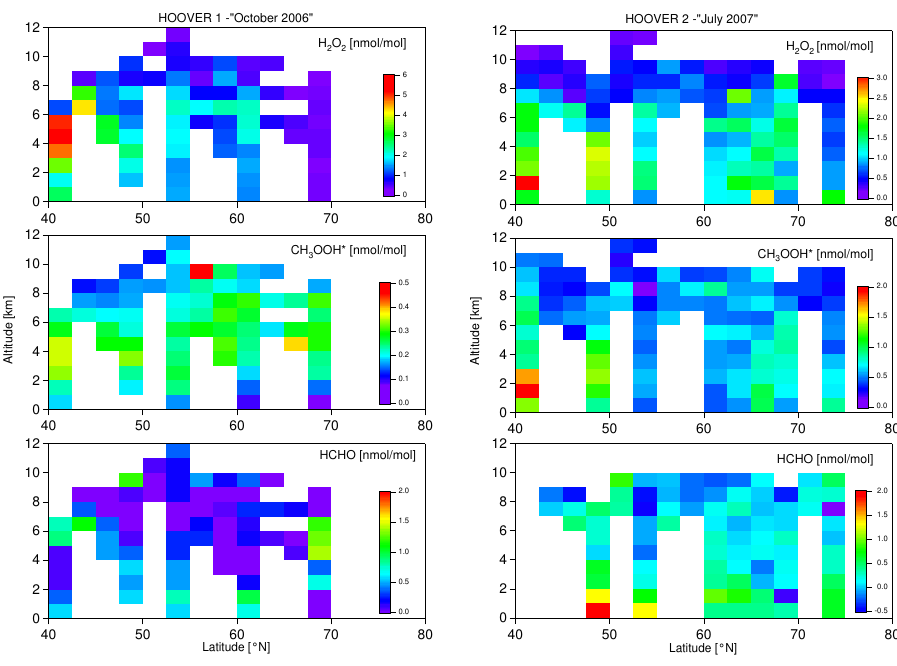
Fig. 3. Data maps for the HOOVER 1 (left) and HOOVER 2 (right) campaigns. Boxes define data subsets over 2 . 5 ◦ latitude sections and a height of 1 km. The colour code depicts median mixing ratios of each box in nmol/mol.